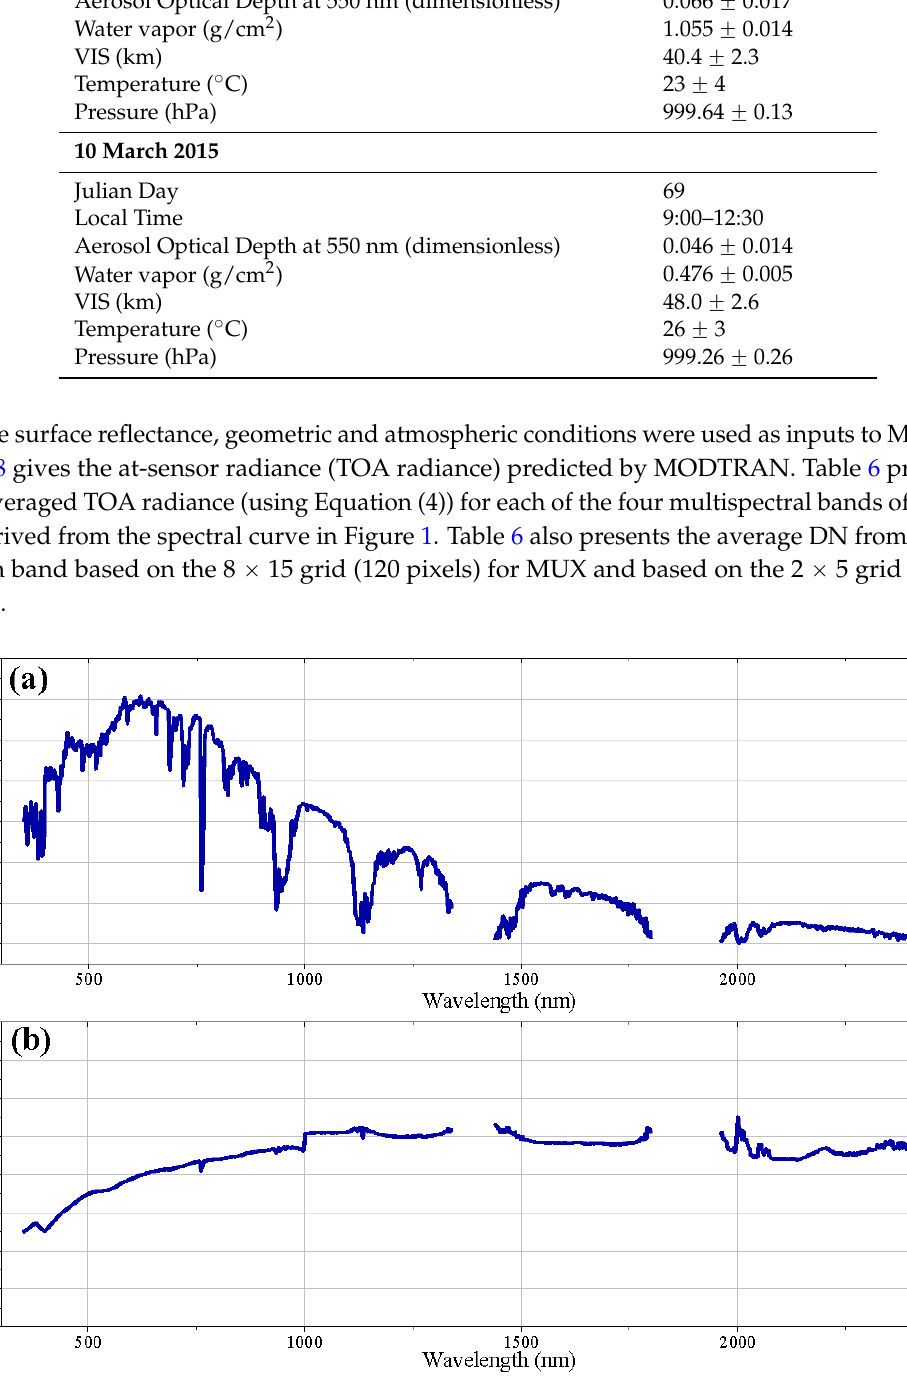
Figure 8. ( a ) Top of Atmosphere radiance predicted by MODTRAN and ( b ) relative uncertainty.